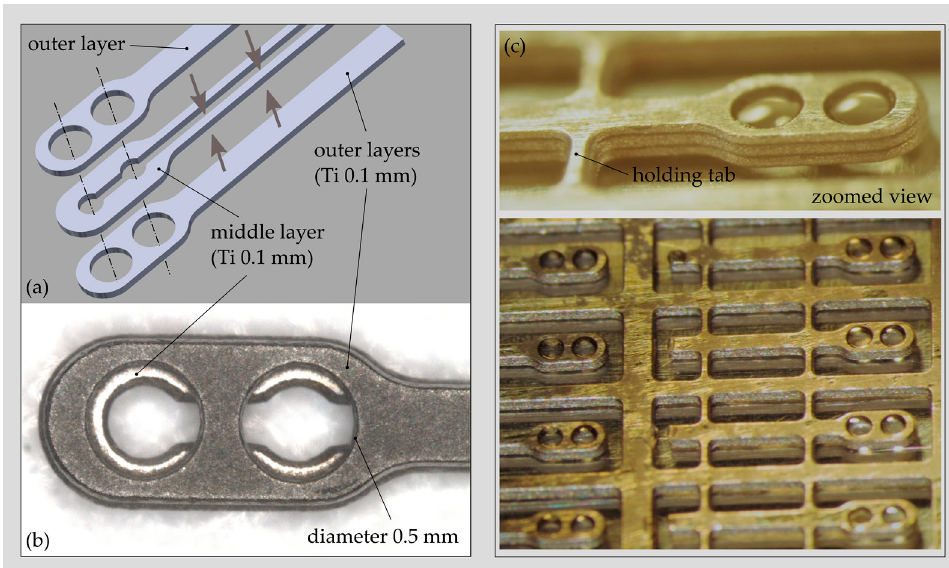
Figure 9. ( a ). CAD drawing showing the three-layer design of the sound receptor (SR) structure, including the geometry of the individual layers. ( b ) The tip region of the bare SR structure fabricated by photo-chemical etching and diffusion bonding. ( c ) SR structures after cavity filling with QPAC 40.